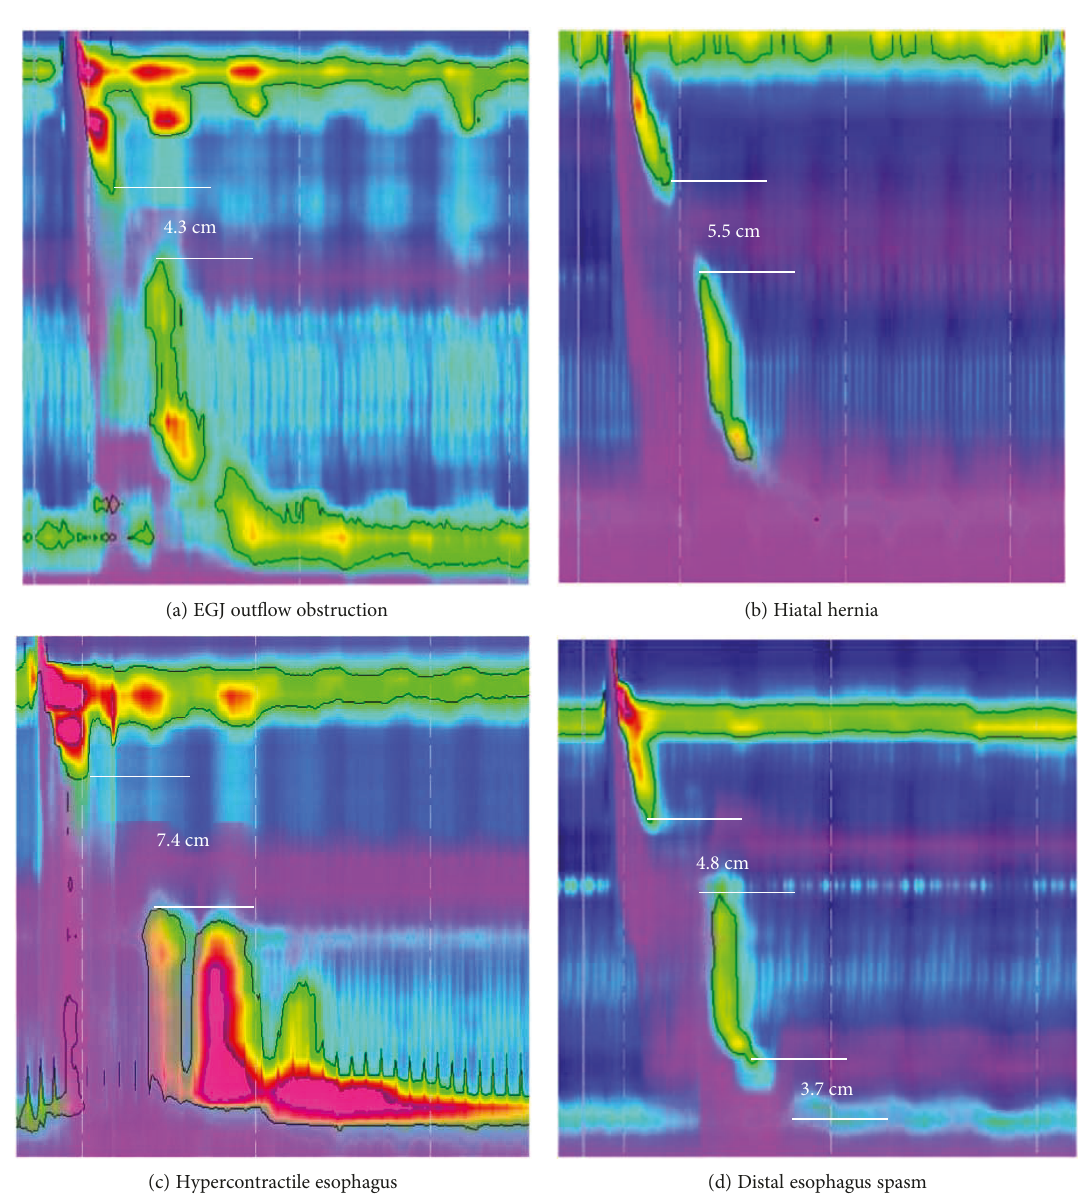
Figure 3: HRIM manifestation of peristalsis and incomplete esophageal transit (ICET). (a) One patient with EGJ out fl ow obstruction showed a 4.3cm break in the 30 mmHg isobaric contour and exhibited ICET. (b) One patient of hiatal hernia had a 5.5cm break in the 30 mmHg isobaric contour and presented ICET. (c) One patient of hypercontractile esophagus (presented hypercontractility of LES) showed a 7.4cm break in the 30mmHg isobaric contour and exhibited ICET. (d) One patient of distal esophagus spasm showed 4.8 and 3.7cm breaks, respectively, and presented